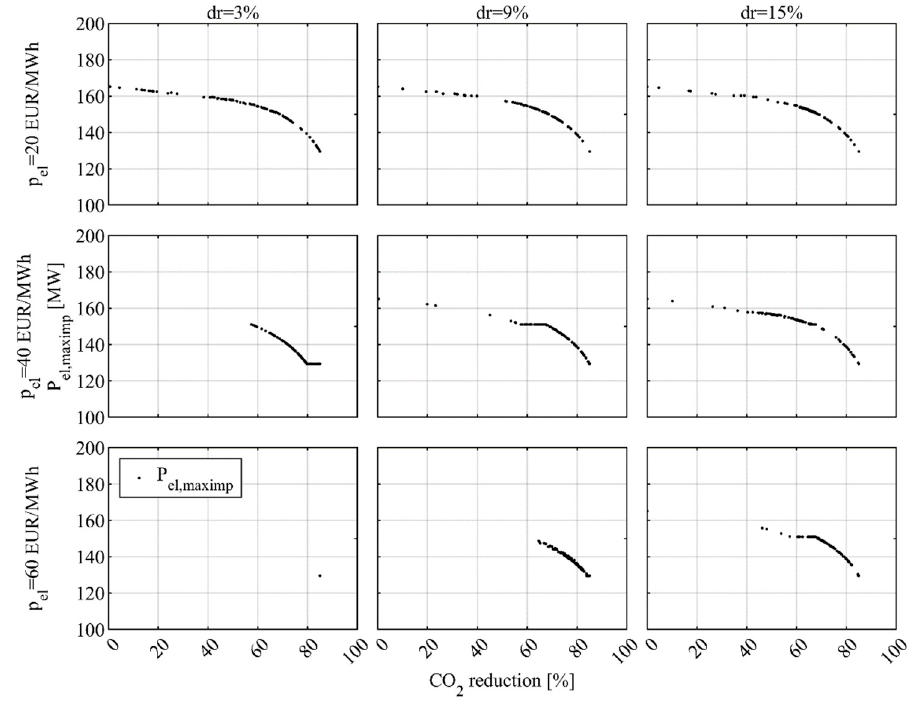
Figure 4. Electricity sector, P el,maximp with three decision variables (PV, WindON and WindOFF) sensitivity analysis for p el and dr .